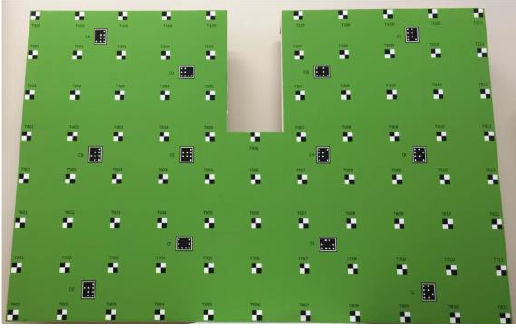
Figure 4. Coded Targets